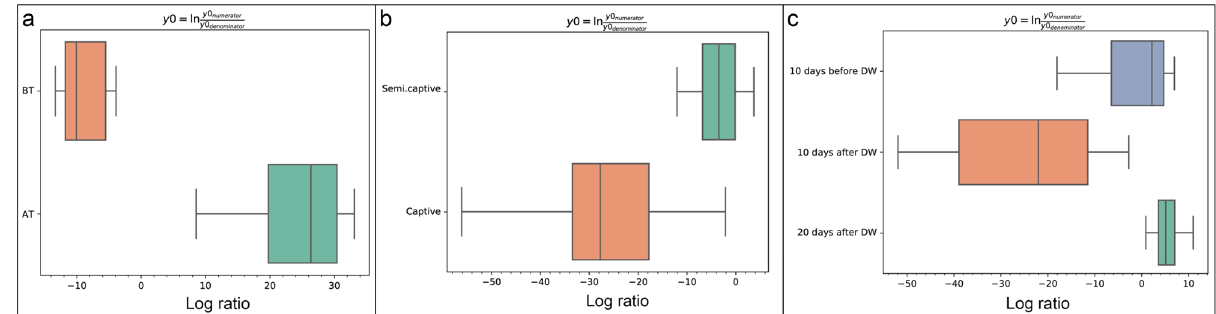
Figure 6. Log ratio of balance of taxa by gneiss analysis of the gut microbiome of Asian elephants. (a) Balance of taxa in microbiome before (BT) and after (AT) translocation. ( b) Balance of taxa in captive against semi captive elephants. ( c) Balance of taxa in relation to deworming (DW) status. Lower values represent a change in the balance toward denominator taxa, while the higher values represent a change toward numerator